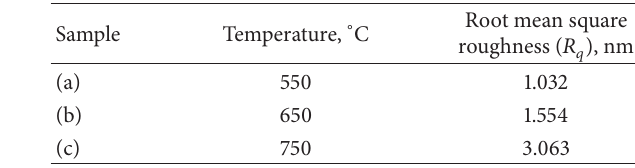
Table 3: Root mean square roughness ( 𝑅 𝑞 ) data for all